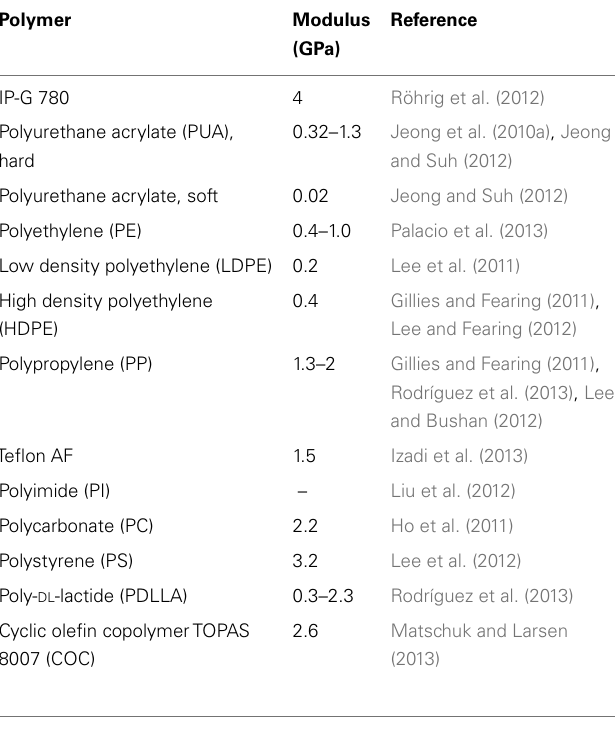
Table 2 | Polymers used for nanostructured dry adhesives.